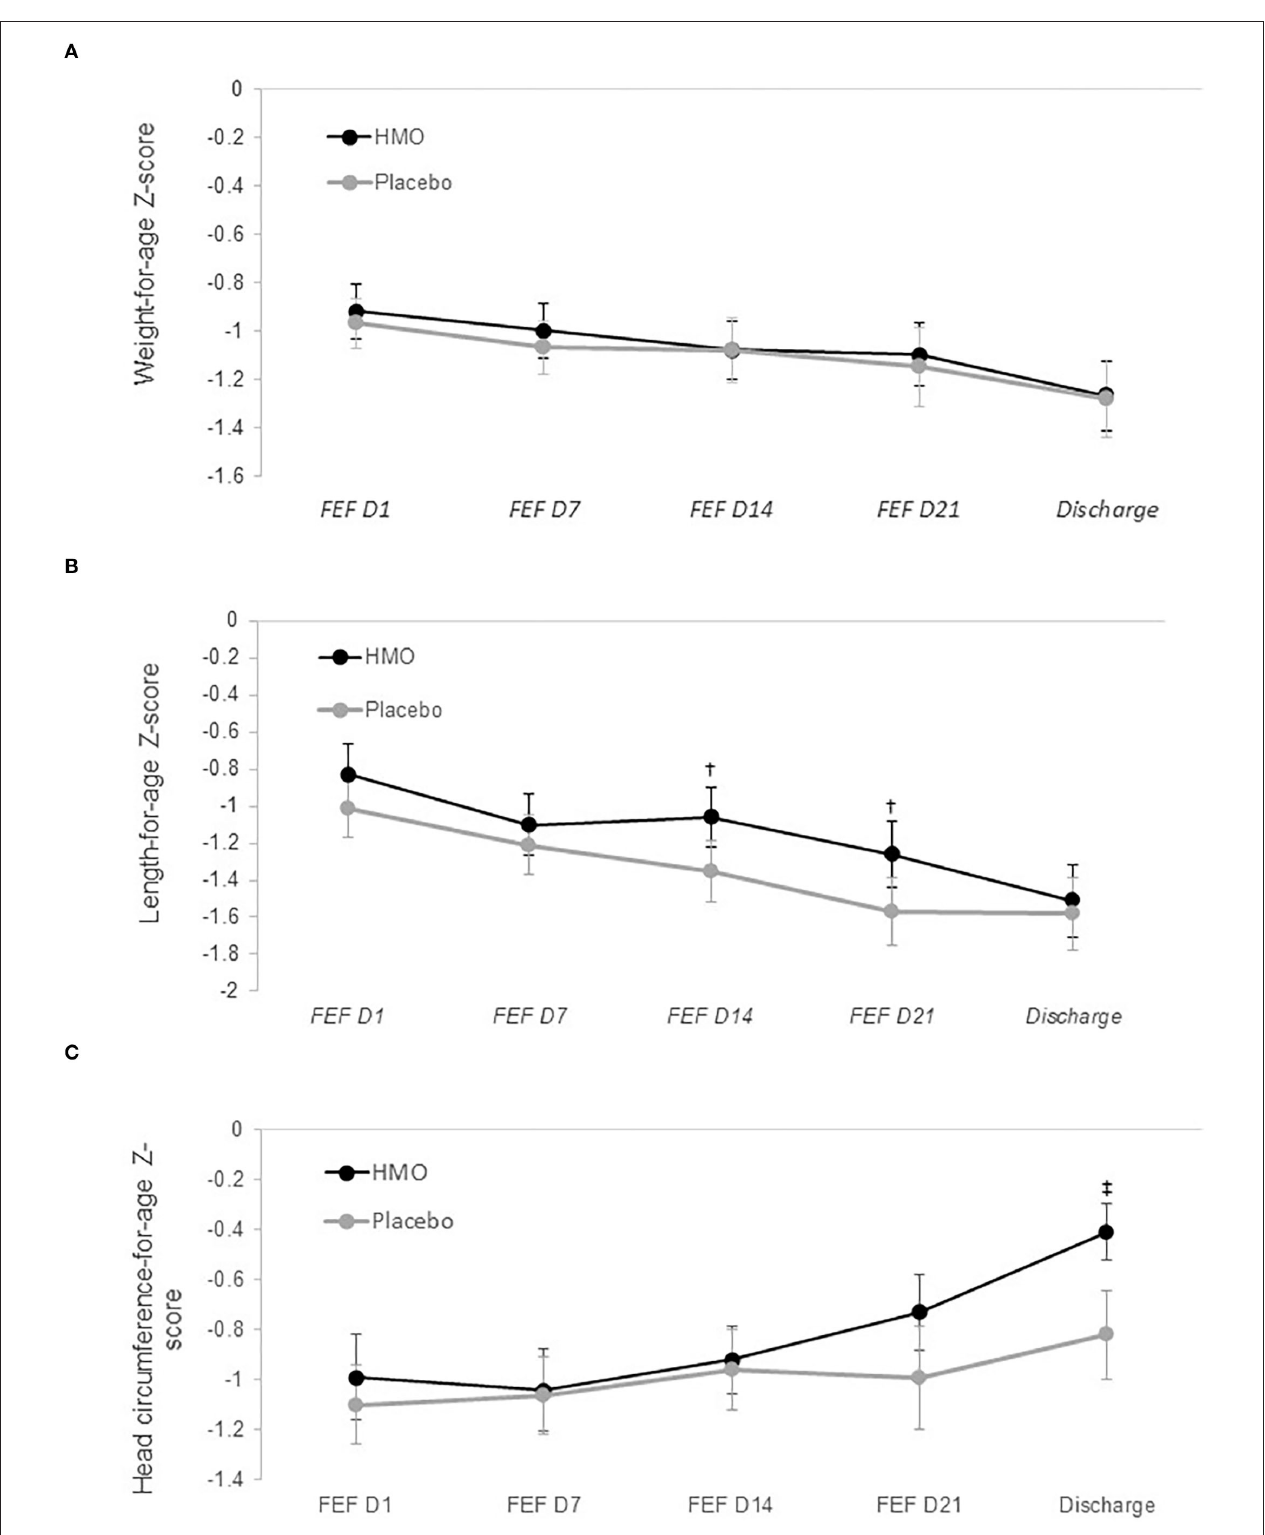
FIGURE 2 | Adjusted mean anthropometric z -scores for weight (A) , length (B) , and head circumference (C) by randomized group. Circles (and whiskers) in graph indicate LS means ( ± 1 SE), which were derived from mixed model with repeated measures, adjusting for measure at birth, measure at baseline, study center, sex, and mode of delivery. FEF, full enteral feeding. † p = 0.037; ‡ p = 0.007.